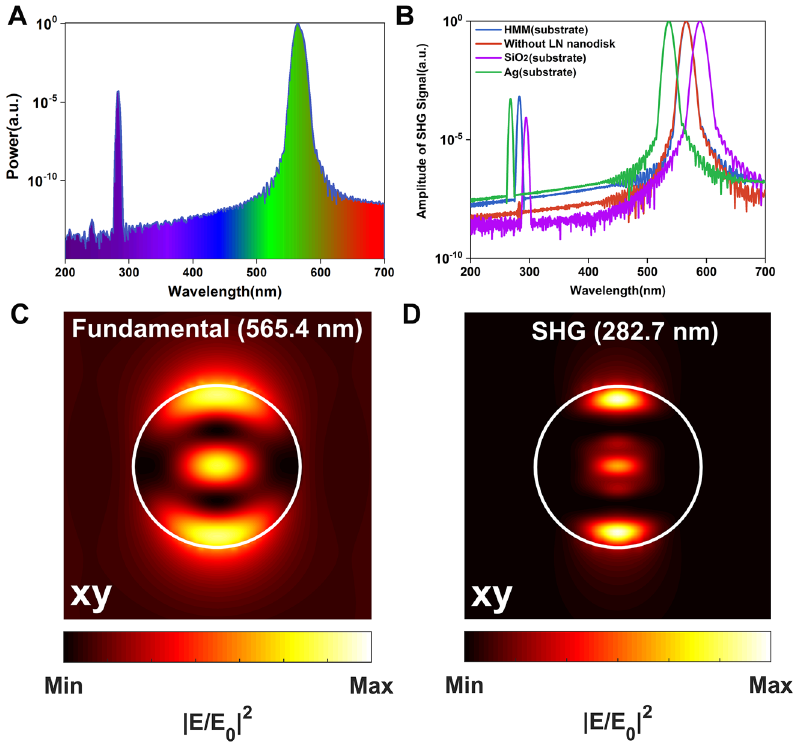
for the proposed nanostructure.